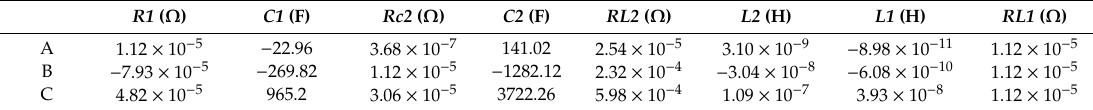
Table 4. Parameter values of the coe ffi cients A, B y C for the elements of the electrical circuit.